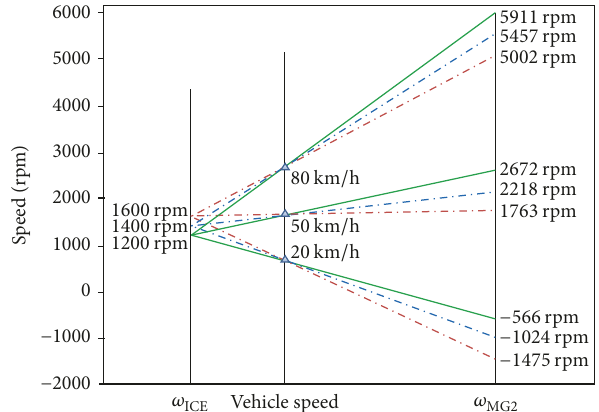
Figure 2: Adjusting MG2 speed to regulate engine operating